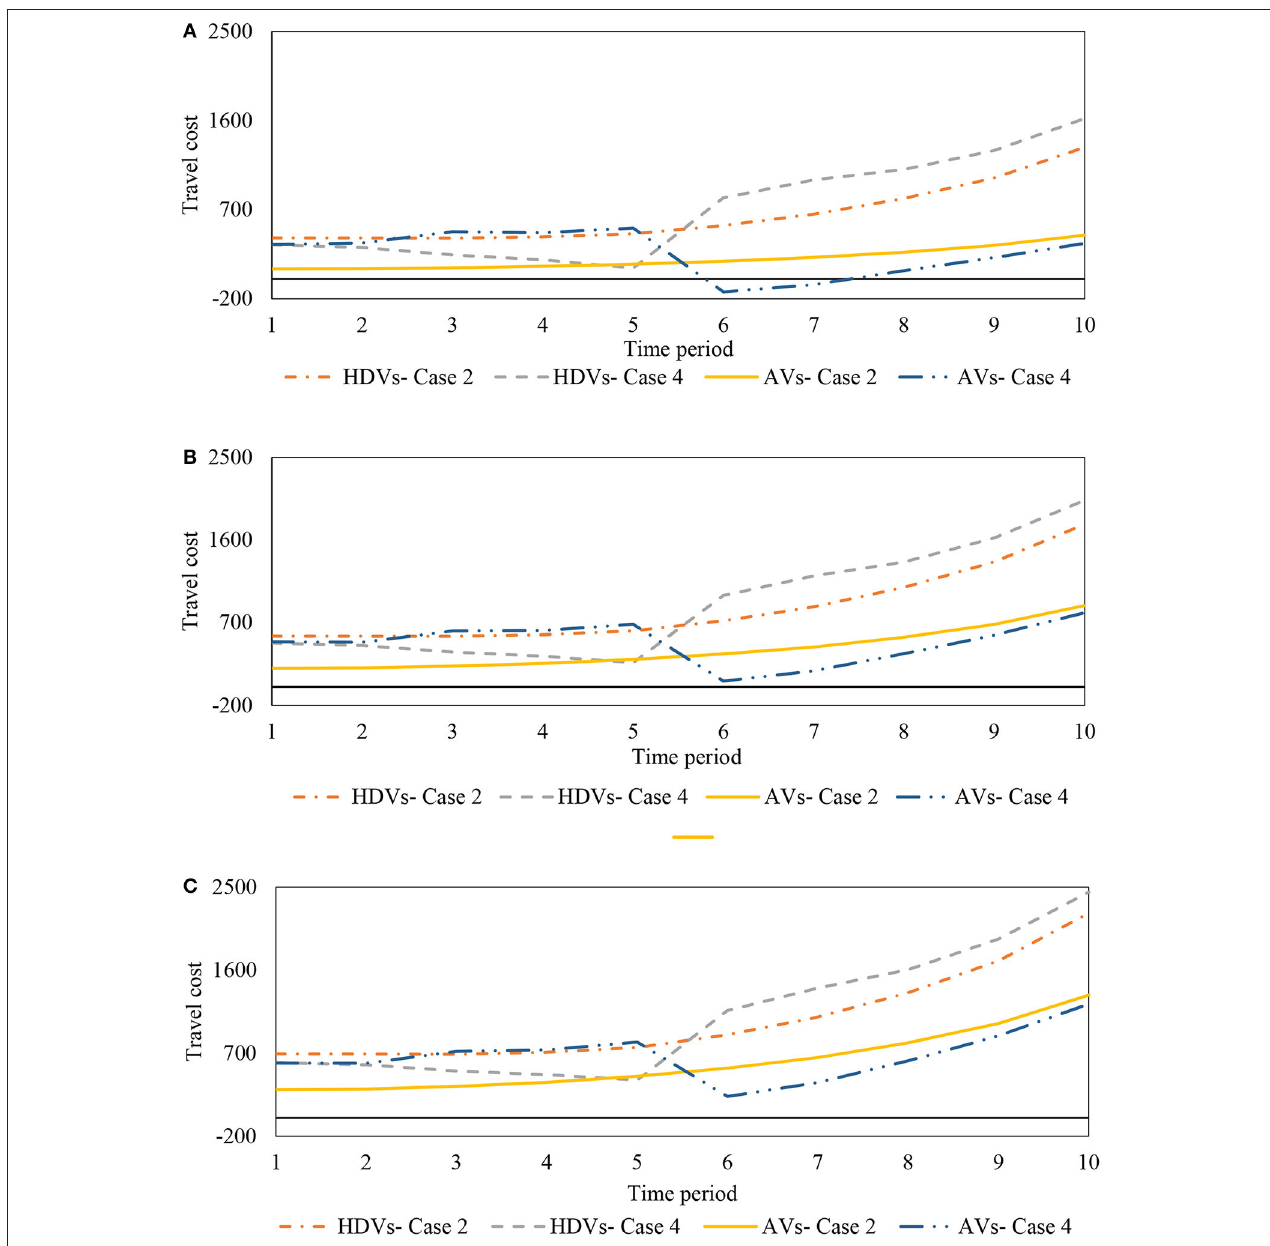
FIGURE 4 | Travel costs of different groups under AV dedicated only and TLMAV design (Cases 2 and 4). (A) Group 1. (B) Group 2. (C) Group